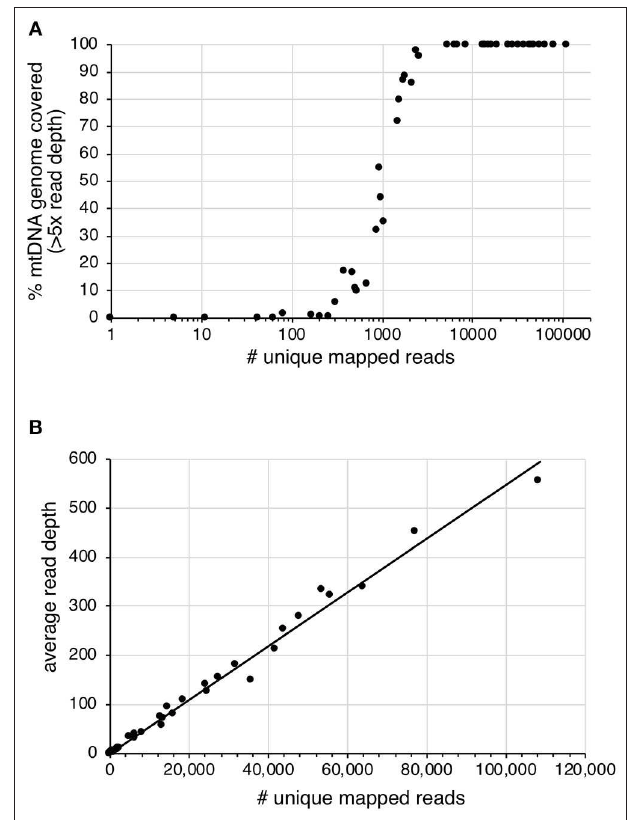
FIGURE 3 | The effect of increased number of unique mapped reads on (A) the percentage of mtDNA genome with > 5 × read depth and (B) the average read depth across the mtDNA